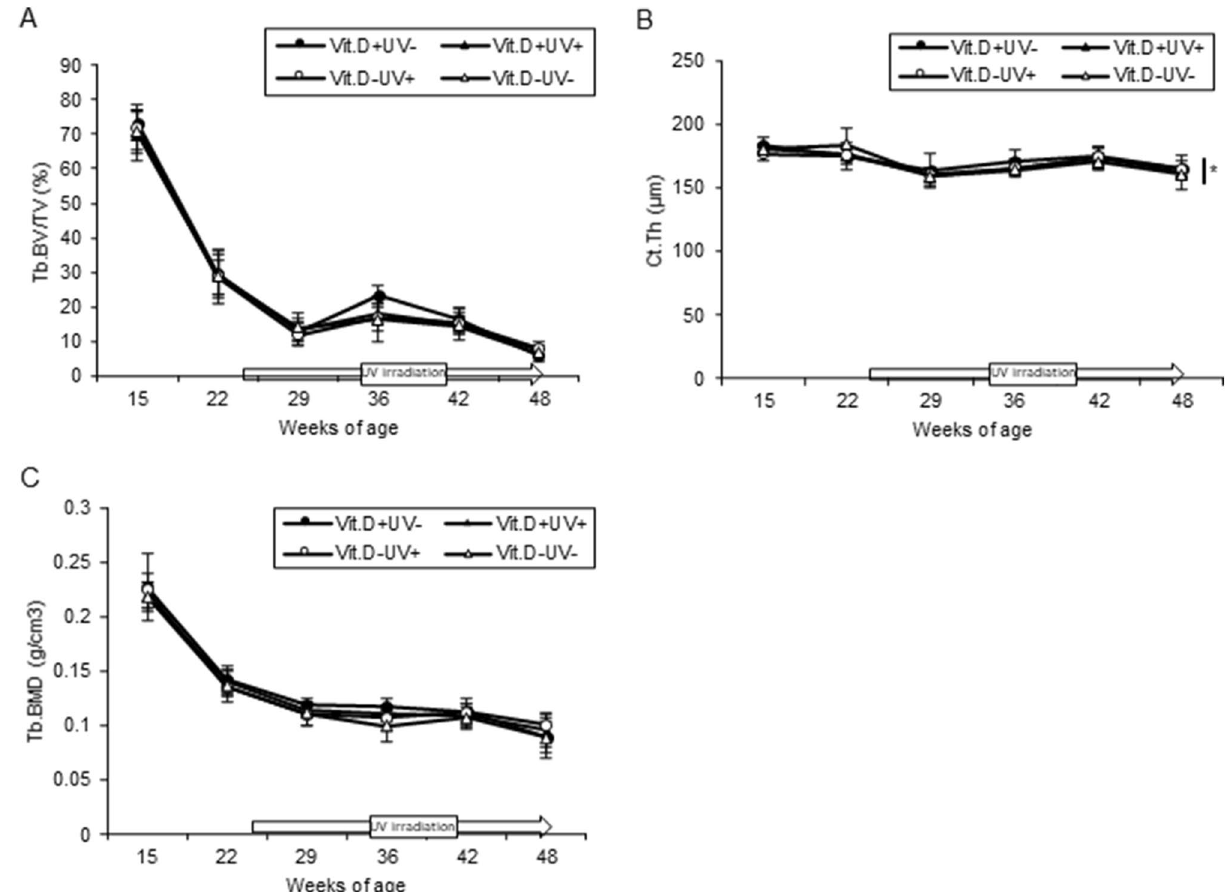
Figure 7. Bone morphological parameters with micro-CT analyses in main study. Each parameter evaluated by micro-CT is compared at 15, 22, 29, 36, 42, 48 weeks of age. ( A ) Trabecular percent bone volume